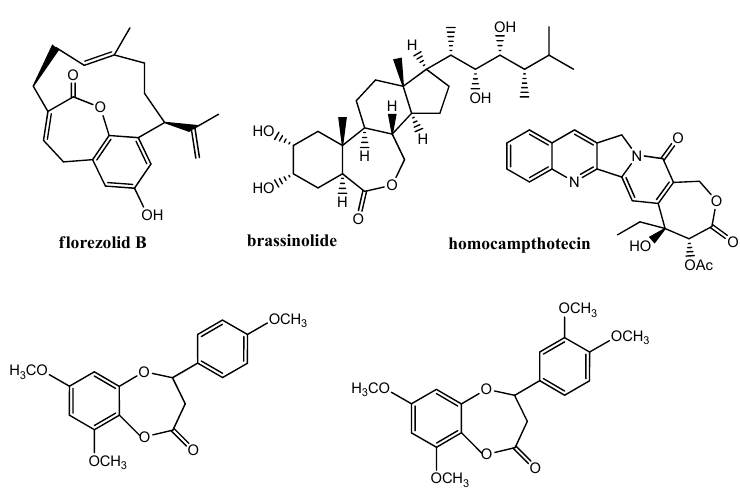
Figure 2. Examples of biologically active ɛ -lactones.